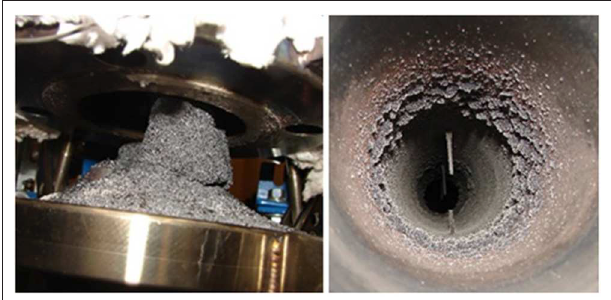
FIGURE 3 | Almond biomass agglomerations. Air fluidization typically resulted in bed material agglomeration (Left) , while steam fluidization typically resulted in wall deposition within the gasifier (Right)